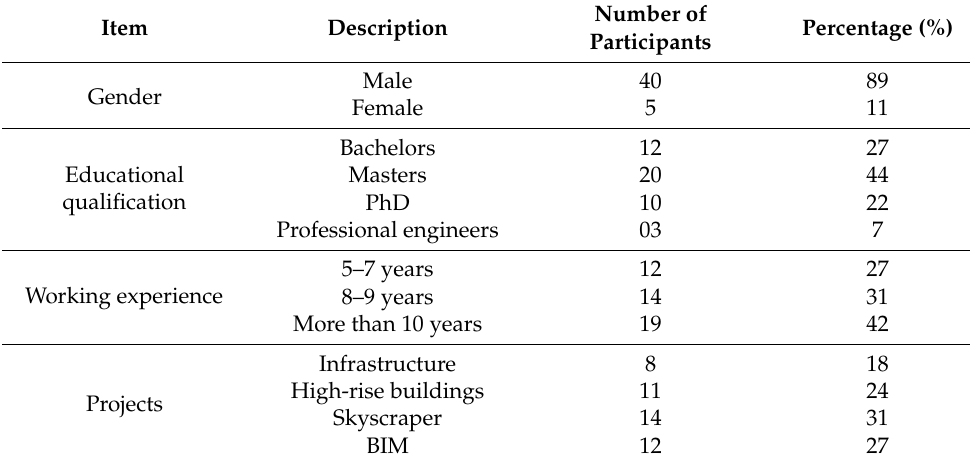
Table 3. Participant demographics (n =